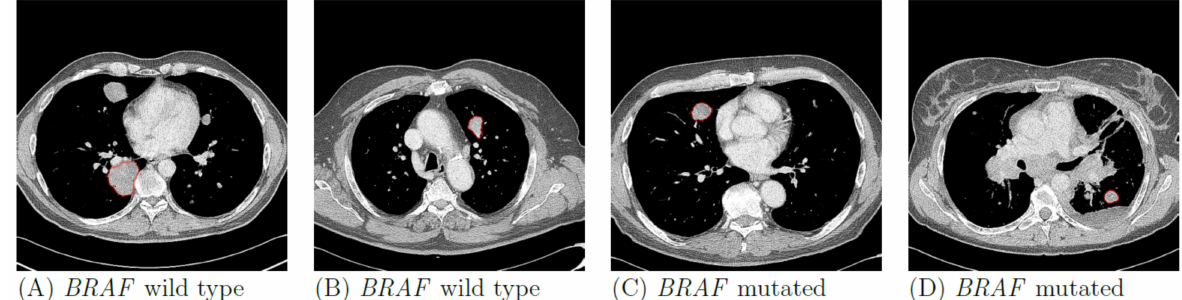
Figure 2. Examples of BRAF wild type ( A , B ) and BRAF mutant ( C , D ) lung metastases of four patients with metastatic melanoma. Contours of the segmentations of the selected metastases are shown in red.